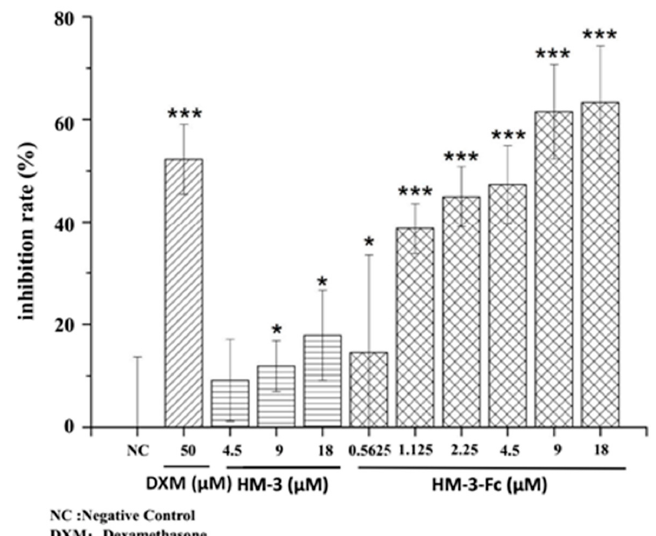
Figure 4. The effects of HM-3-Fc on splenic lymphocytes viability. Cells were stimulated with ConA,